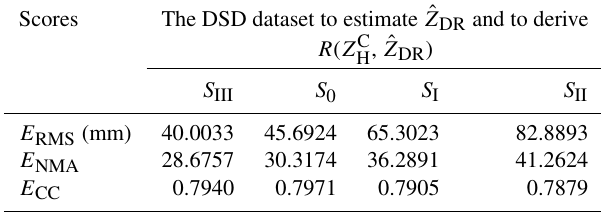
Table 2. Evaluation scores of R ( Z C datasets ∗